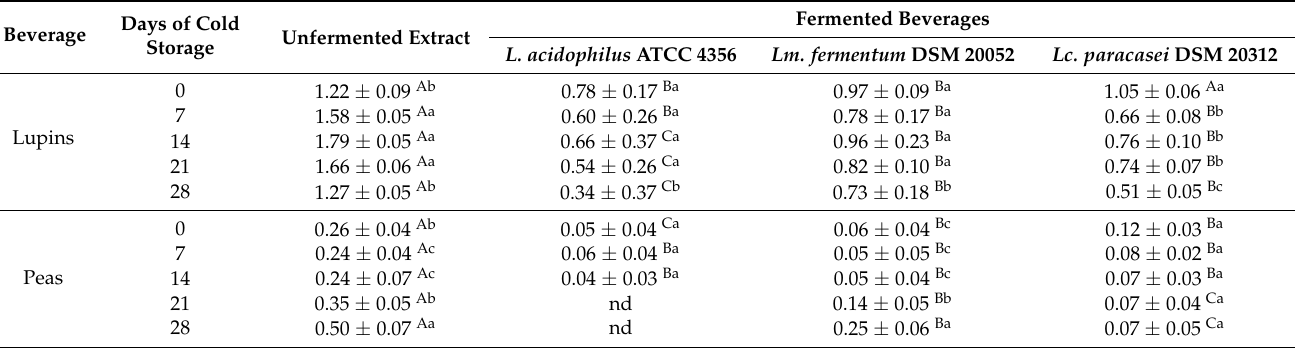
Table 7. Concentration of total protein (mg mL − 1 ) of fermented beverages and in unfermented water extracts during 28 days of refrigerated (4 ◦ C) storage.